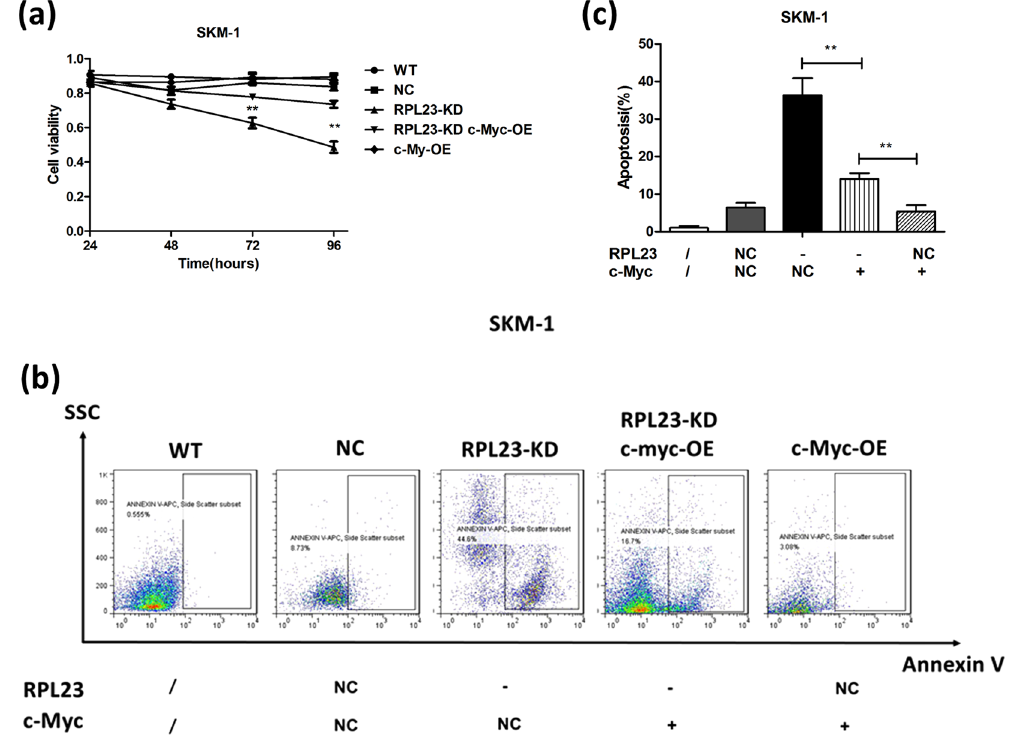
Figure 4. Expression of c-Myc overcomes RPL23-KD-induced viability suppression and apoptotic tendency in SKM-1 cells. ( a ) Growth curve of SKM-1 cells infected with LV-RPL23-RNAi expression vectors alone or together with CMV–c-Myc expression plasmid vectors after superinfection at the indicated time point. Suppressive proliferation of RPL23-KD cells was overcome by CMV-driven expression of c-Myc (p < 0.01). ( b , c ) Forty-eight hours after superinfection, cellular apoptosis was measured by Annexin V single-staining, and induced expression of c-Myc alleviated the high apoptotic potential that is mediated by depletion of L23. Unpaired Student’s t tests were used to calculate all p values shown throughout the figure. The data are expressed as the means ± S.E.M. WT: non-transfected group (used as blank control); NC: superinfected with two empty vectors (used as negative control); RPL23-KD: superinfected with LV-RPL23- RNAi and CMV-c-Myc-NC; RPL23-KD/c-Myc-OE: superinfected with LV-RPL23- RNAi and CMV-c-Myc and c-Myc-OE: superinfected with CMV-c-Myc and LV-RPL23-NC. /: non-treated; − : decreased expression; + : induced expression; NC: transfected with empty vectors. * p < 0.05; ** p < 0.01; *** p <